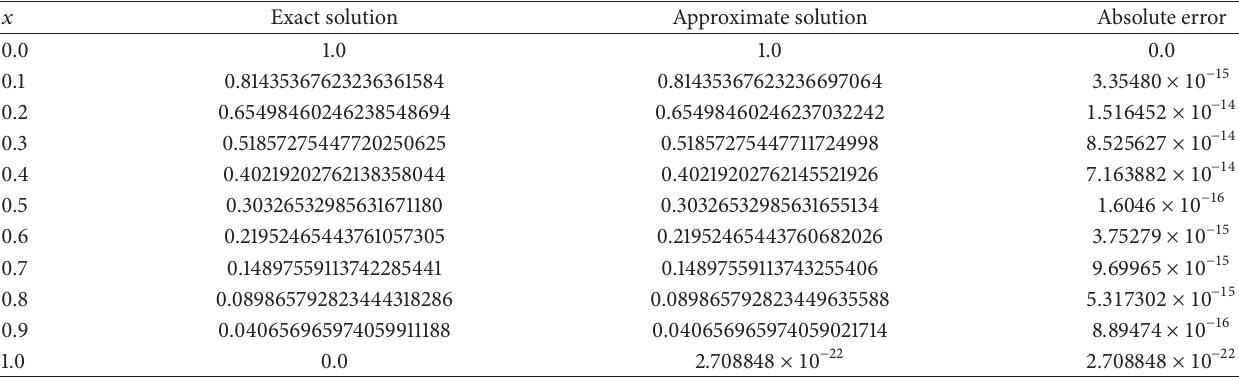
Table 5: Numerical results for Example 12 (time (s): 5.234).